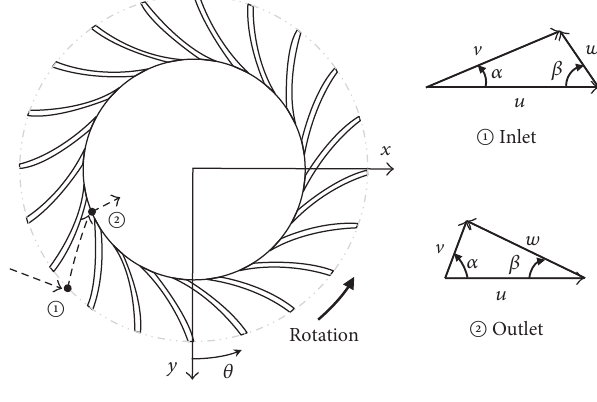
Figure 11: Velocity